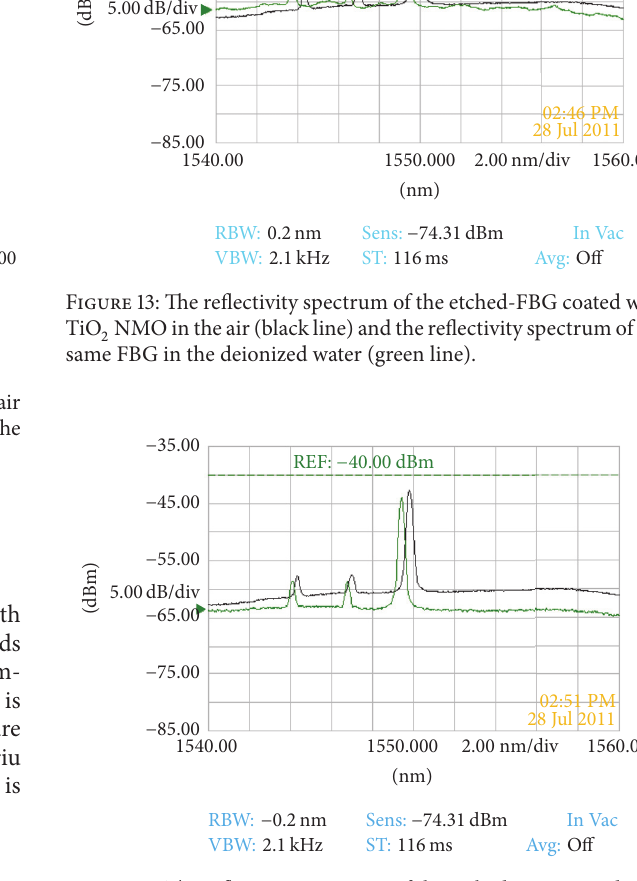
Figure 14: The reflectivity spectrum of the etched-FBG coated with TiO 2 NMO in the air (black line) and the reflectivity spectrum of the same FBG in the saline water (green